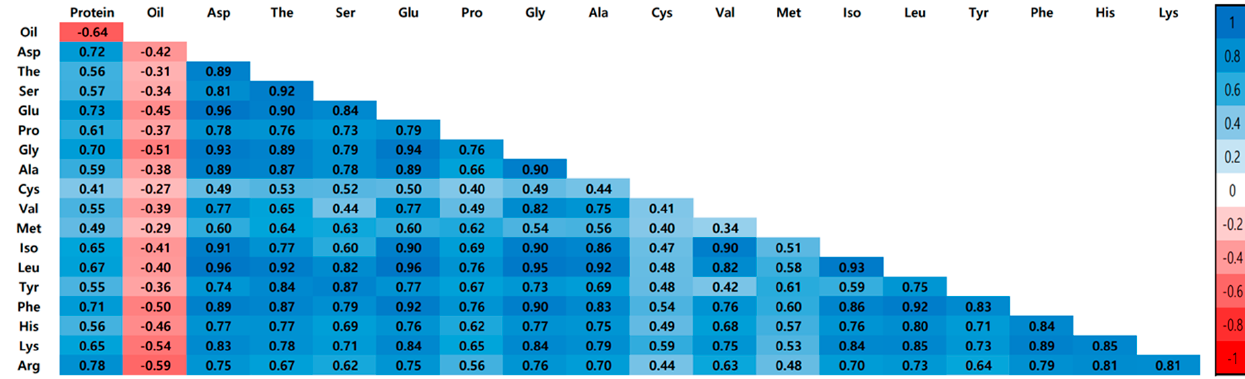
Figure 3. Correlation analysis among the seed component of 203 wild soybean accessions for the average of 2015 and 2016. Asp, aspartic acid; Thr, threonine; Ser, serine; Glu, glutamic acid; Pro, proline; Gly, glycine; Ala, alanine; Cys, cysteine; Val, valine; Met, methionine; Iso, isoleucine; Leu, leucine; Tyr, tyrosine; Phe, phenylalanine; His, histidine; Lys, lysine; Arg, arginine. All components of each have a p -value of < 0.001.